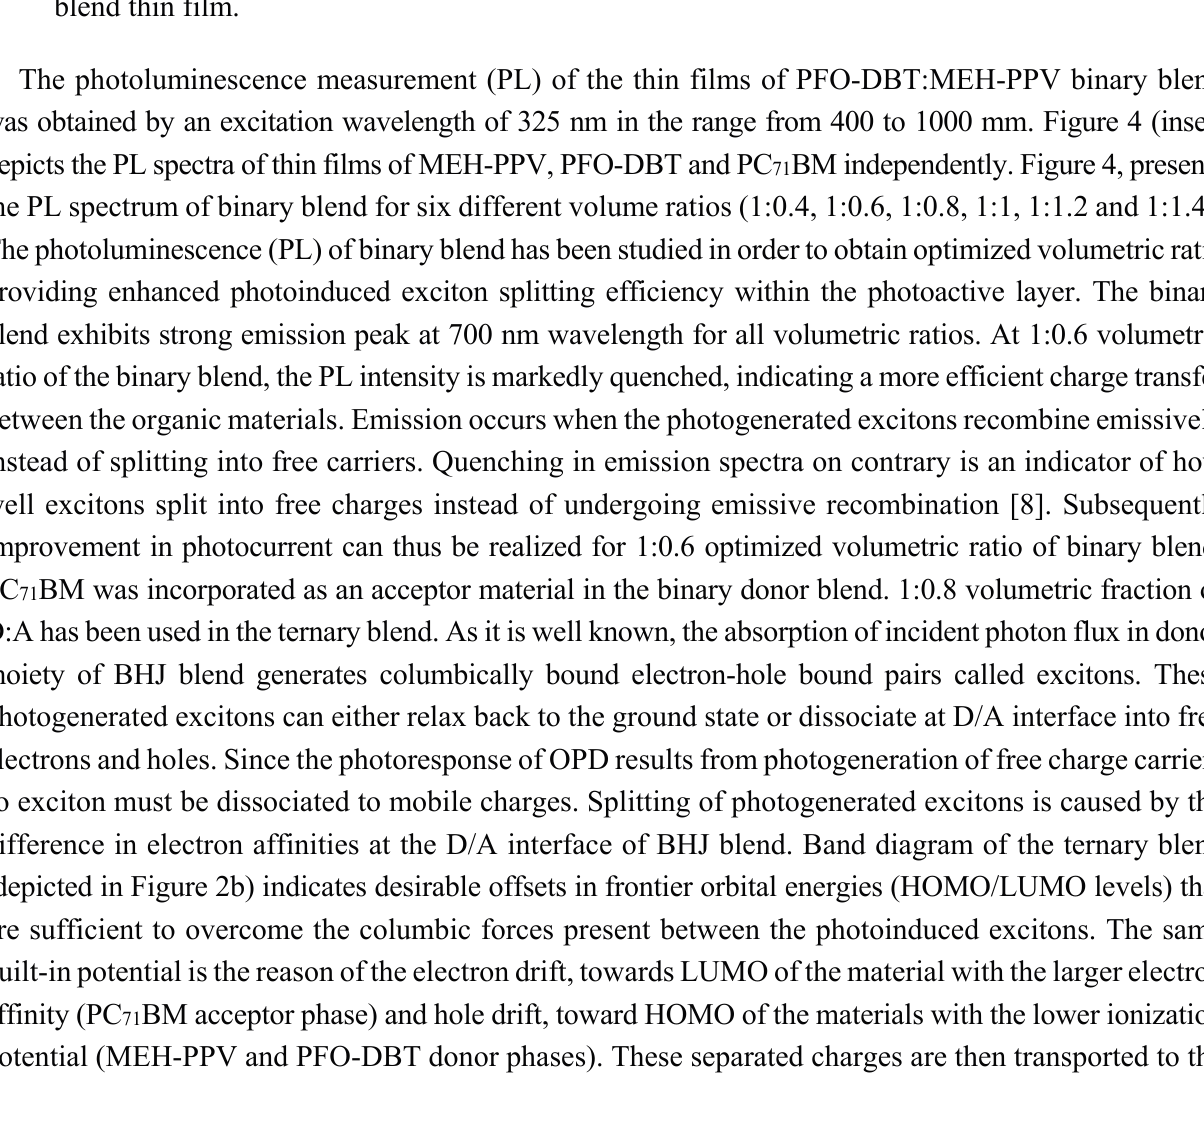
Figure 3. UV-Vis spectra of PFO-DBT, MEH-PPV, PC 71 BM neat materials and their ternary blend thin